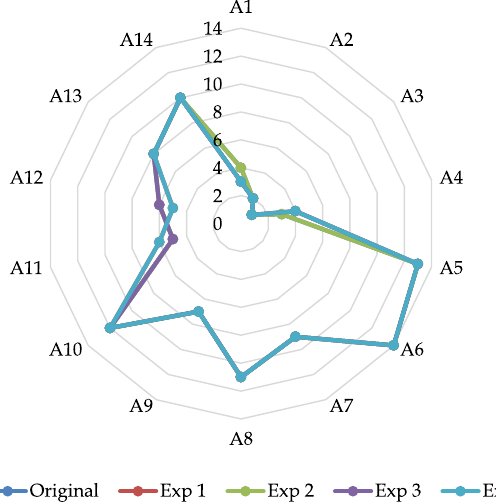
Fig. 1 Results of the sensitivity